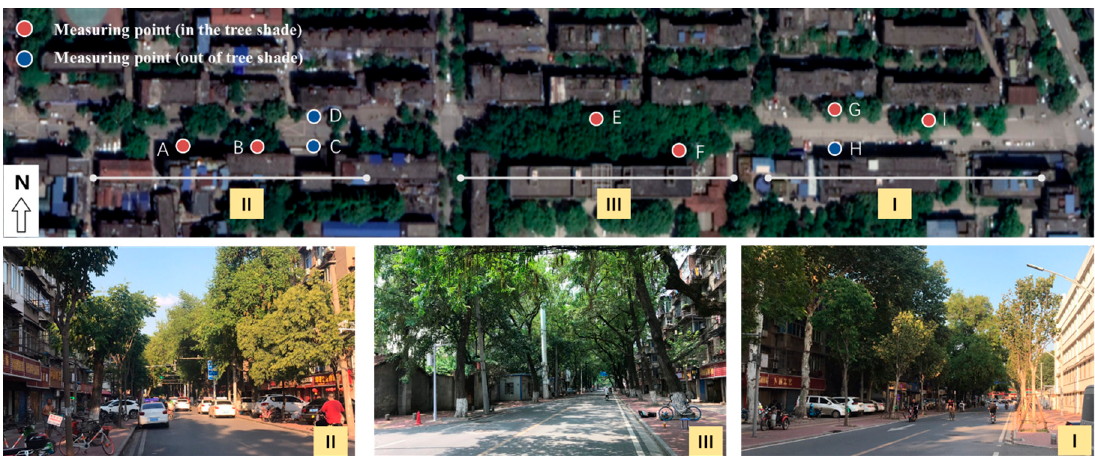
Figure 2. Aerial view of the street highlighting the extent of street segments according to the percentage of tree coverage. A–I indicate the nine measuring points. Table 1. Characteristics of the street used for data collection 1